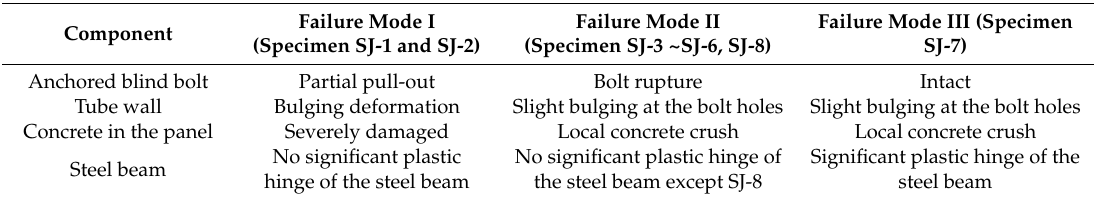
Table 3. Representative failure modes of the